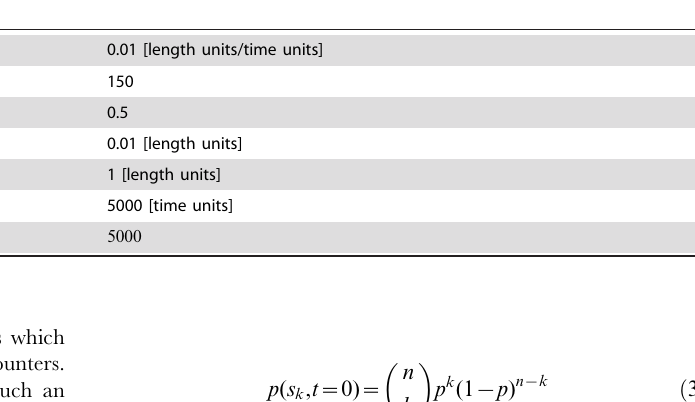
Table 1. Parameters for the microscopic simulation of the virtual swarm using